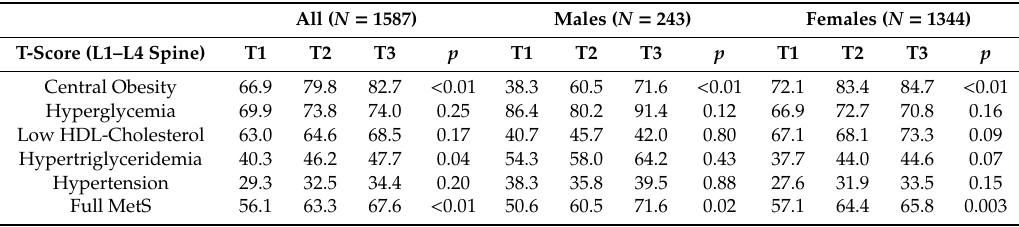
Table 2. Prevalence of metabolic syndrome (MetS) components in tertiles of T-score (spine) according to